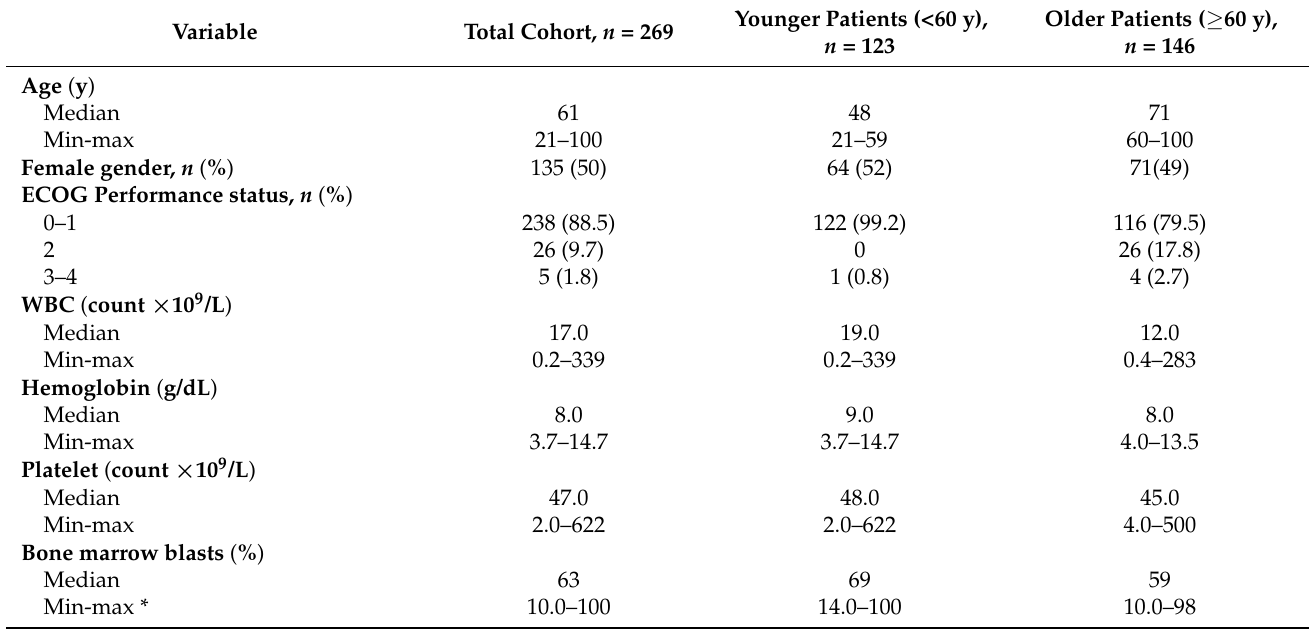
Table 1. Demographic and laboratory baseline characteristics of the study